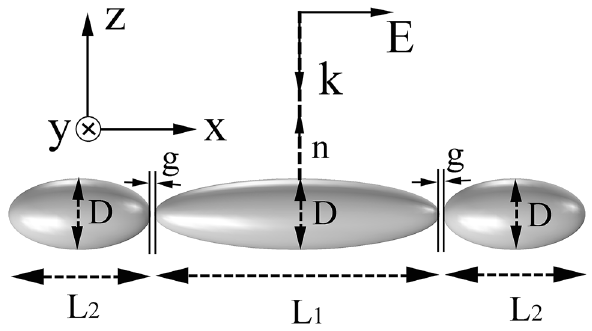
Figure 1. Excitation model of the silver nanorice trimer. The trimer locates in the x–y plane, with its normal direction n along the negative direction of the z axis. Linearly polarized light illuminates this trimer with normal